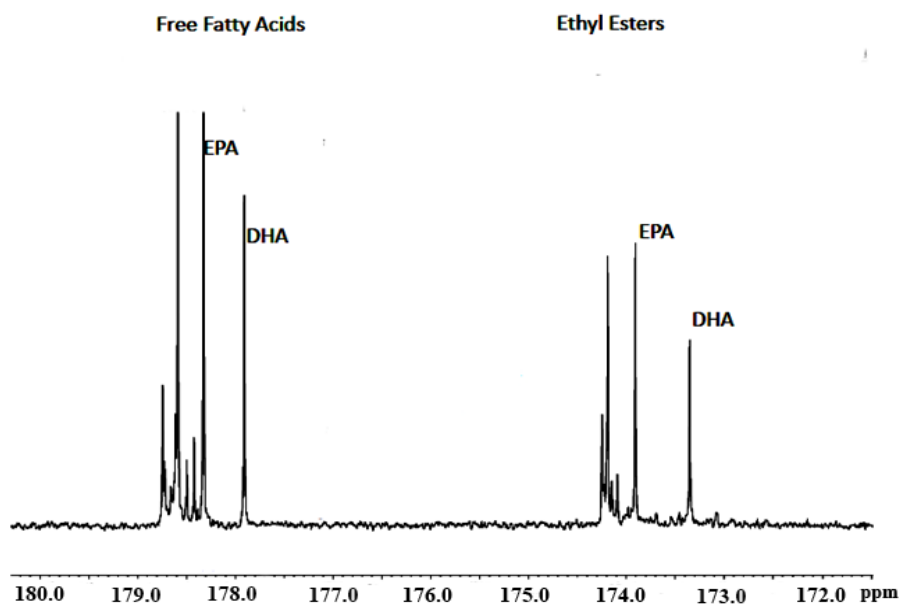
Figure 8. 13 C-NMR simultaneous detection of free fatty acids (left side) and their alkyl esters (right side). Free download from: http://www.ilps.org/index.php/Standardized_Methods.html. Table 11. 13 C-NMR peak assignments of the carboxyl and the ester carbonyl region of UFAs in CDCl 3 .